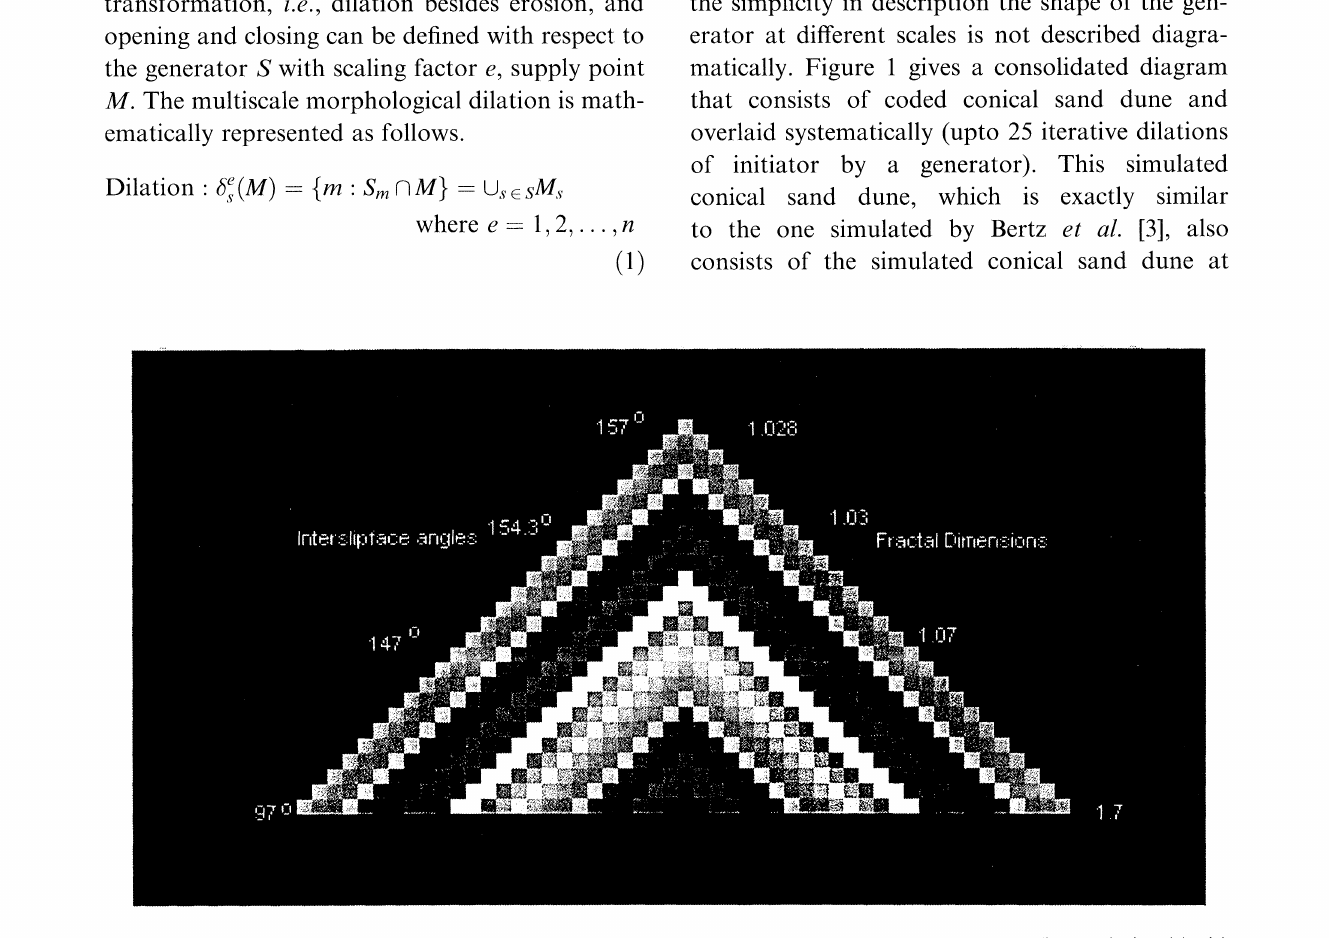
FIGURE The sand dune shown is the digital image simulated from supply point (initiator) and a generator (inverted triangle) with center as origin and bottom as vertices. Simulation of sand dune is shown at different degrees of morphological dilations of initiator by generator. The fractal dimensions at the respective growth levels of Sand dune are shown at the right side of the axis. At the left, the interslipface angles have been depicted for respective degree of sand dune growth. To have a visual appeal, the simulated sand dune is enlarged. Hence the diagram at the high iterates of dilations are protruding, in contrast to the interslipface angles